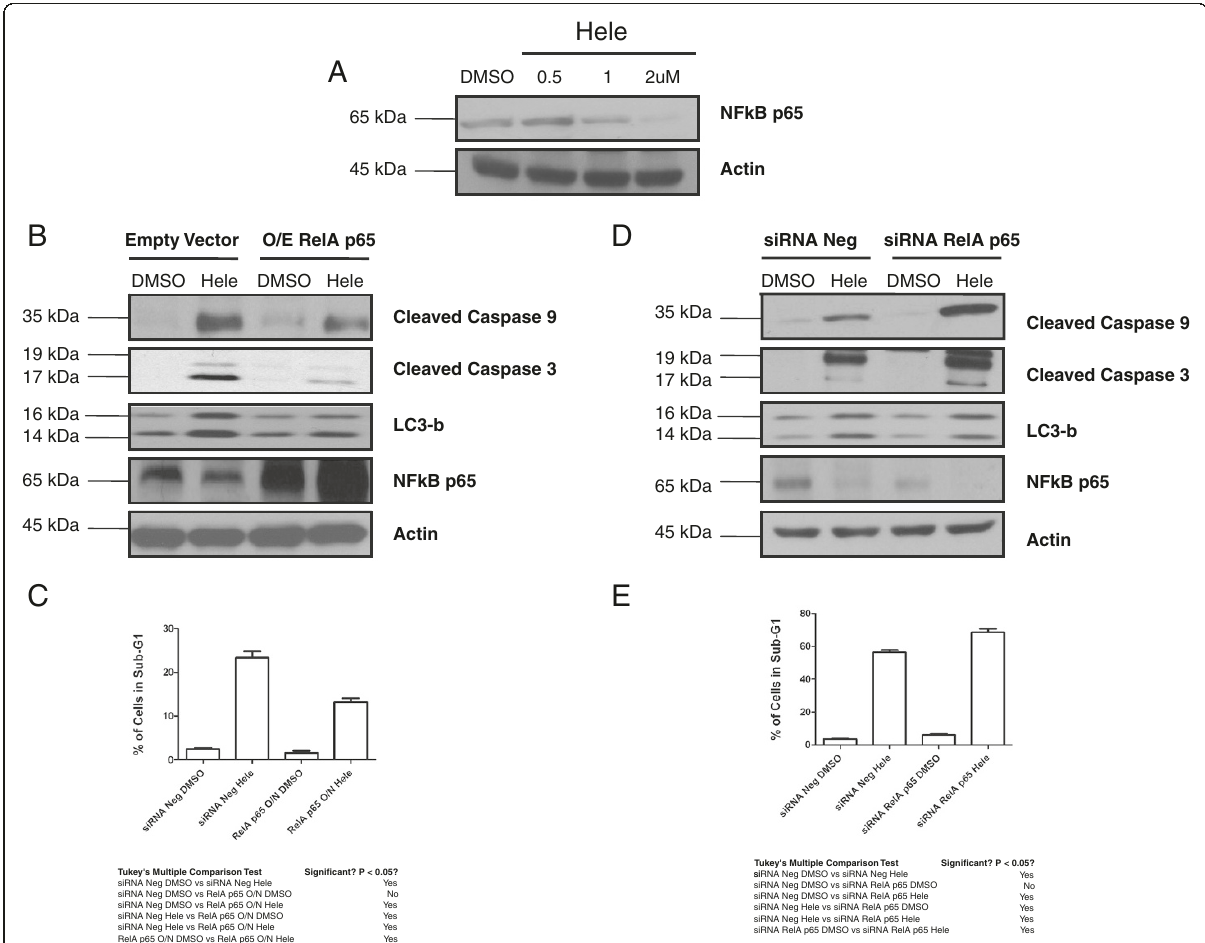
Figure 7 Repression of NF- κ B p65 expression by Helenalin is necessary for caspase cleavage and autophagy. ( A ) A2750 cells were treated with increasing concentrations of helenalin for 24 h, following which cells were harvested and cell lysates prepared and subjected to immunoblot analysis for NF- κ B. ( B ) A2780 cells were transfected with an empty vector or vector over-expressing RelA p65. 24 h post transfection, cells were treated with DMSO or 2uM helenalin for 24 h,and harvested for immunoblot analysis for cleaved caspase 3 and 9, LC3-B or NF- κ B p65 or ( C ) trypsined and analyzed by FACS for precent of cells in sub-G1. One way ANOVA was performed for sub-G1 cells between control (DMSO) and treatment groups, and significant differences were observed between the groups as indicated in Figure 7C. Categories significant after multiple comparison are marked as “ Yes ” .(p-value < 0.05; Tukey ’ s multiple comparison test). ( D ) A2780 cells were transfected either with a non- targeting siRNA (siRNA Neg) or siRNA targeting RelA p65. 24 h post transfection, cells were treated with DMSO or 2uM helenalin for 24 h and harvested for immunoblot analysis for cleaved caspase 3 and 9, LC3-B or NF- κ B p65 or ( E ) trypsined and analyzed by FACS for percent of cells in sub-G1. One way ANOVA was performed for sub-G1 cells between control (DMSO) and treatment groups, and significant differences were observed between the groups as indicated in Figure 7E. Categories significant after multiple comparison are marked as “ Yes ” .(p-value < 0.05; Tukey ’ s multiple comparison test). All experiments were performed in biological triplicates and actin was used as a loading control for immunoblot